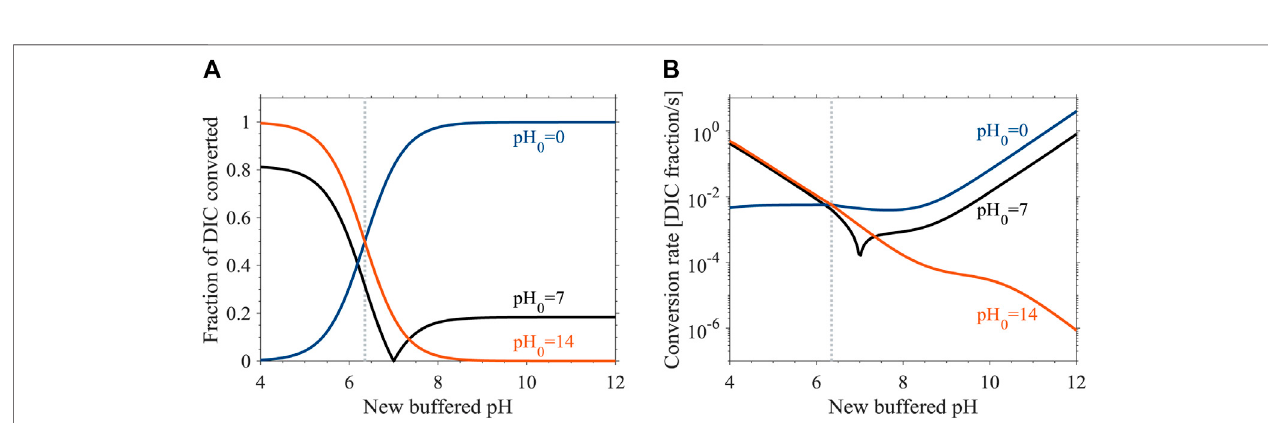
FIGURE1| Equilibration times ofDICinfreshwaterat 25 ° CduringapHtransition (A) inbuffered solutions( Eq.13 )and in (B) unbufferedsolutions(ascalculatedby our numerical model). The pH of the initial solution ( “ pH 0 ” ) is given in the fi gure legends, and a vertical line marks the pKa1 value. In panel B, we illustrated equilibration timesfor10 mM DIC (thicklines), enveloped by equilibration timesfor1 and 100 mM DIC(thin lines). See Supplementary Figure S1 for anenlargedversion ofpanel B.